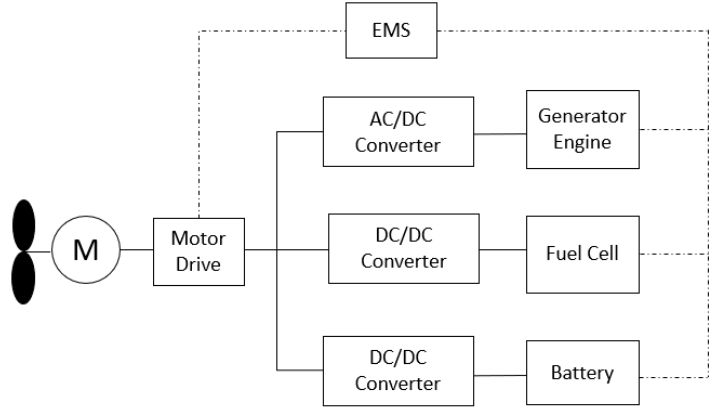
Figure 1. Generator–battery hybrid system using EMS.